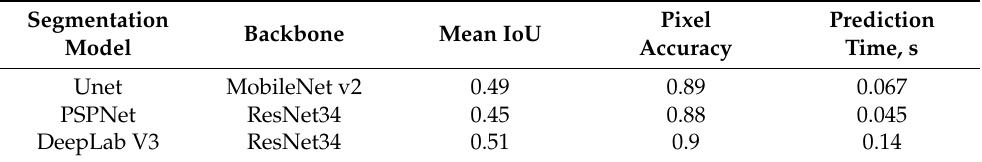
Table 1. Comparison of the training results of the models under